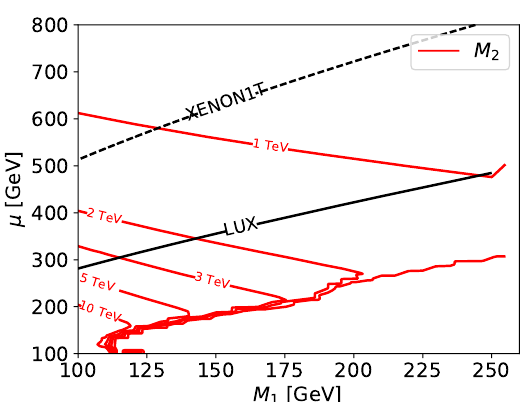
Figure 5 . The upper bound on M 2 that can explain the muon g (cid:0) 2 discrepancy at the 1 (cid:27) level in the BHL scenario. The other parameters are the same of the right panel of (cid:12)gure